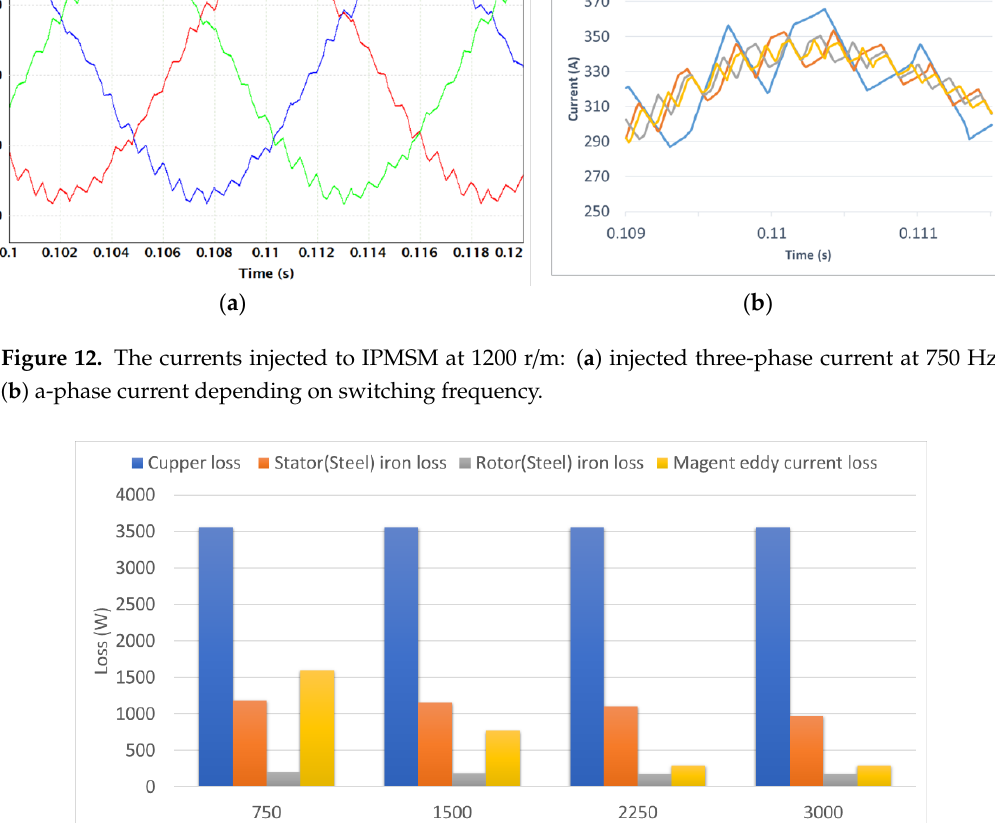
Figure 13. The power loss analysis result of IPMSM at 1200 r/m depending on f sw .